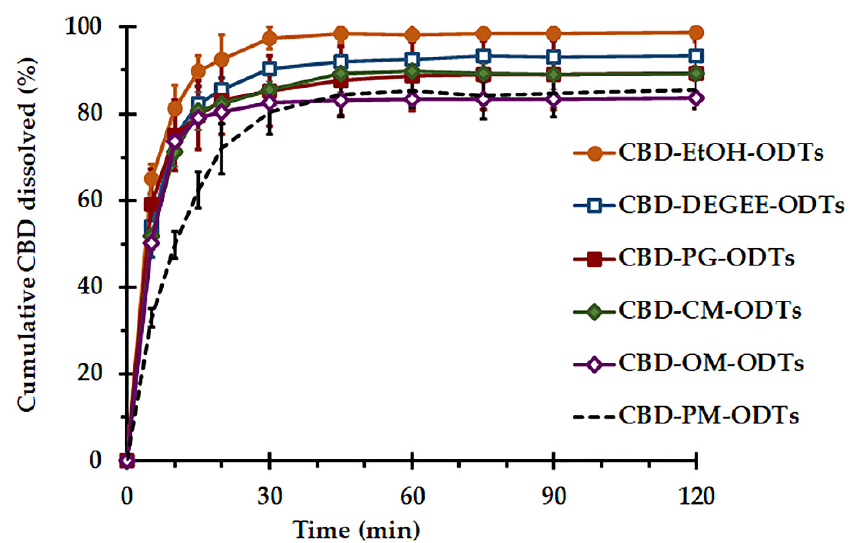
Figure 3. In vitro dissolution of CBD from CBD ODTs under sink conditions at 37 ± 0.5 °C (mean ± SD, n = 6). CBD ODTs were composed of 8% SSG and compressed at a sufficient compression pressure (3–4 MPa) to yield tablets with a hardness of 31 ± 2 N. Table 4. CBD content and in vitro dissolution parameters of CBD ODTs containing 8% SSG and having the hardness of 31 ± 2 N.